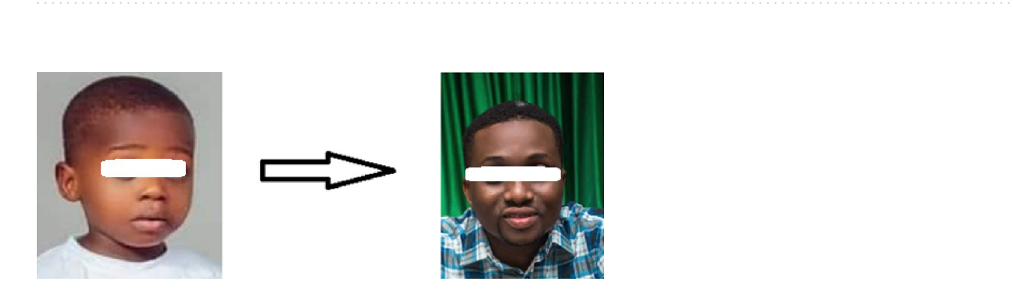
Figure 3. Skin and facial hair during the first stage of